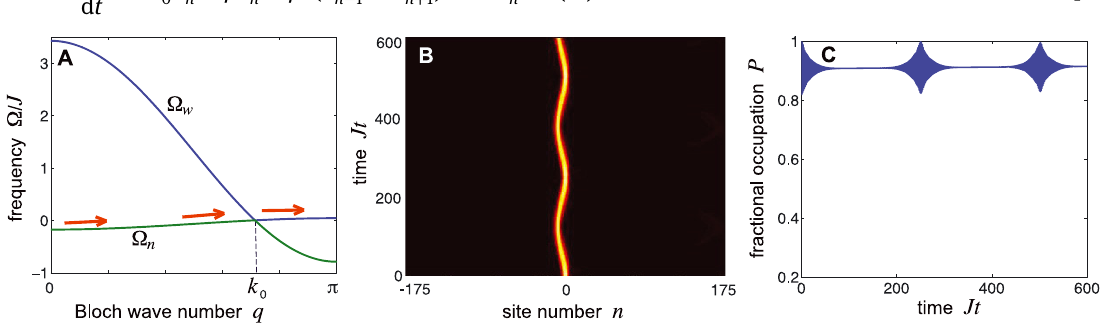
Figure 3: Bloch oscillation dynamics in the BIC crystal with the same parameter values as in Figure 2B and for a gradient F ∕ J = 0 . 025. The initial excitation condition is a Gaussian wave packet a external gradient F induces a drift of the Bloch wave number according to q ( t ) = q arrows. When the wave number q reaches the crossing point q = k periodic motion, remaining trapped in the narrow (BIC) band Ω depicts on a pseudo color map the temporal evolution of the amplitudes | a temporal evolution of the fractional optical power P ( t ) trapped in the cavities, defined by Eq. (33) , is shown in panel (C). Note that during the entire Bloch oscillation (BO) period, the optical power remains mostly trapped in the optical cavities, with small excitation of the resonators in the